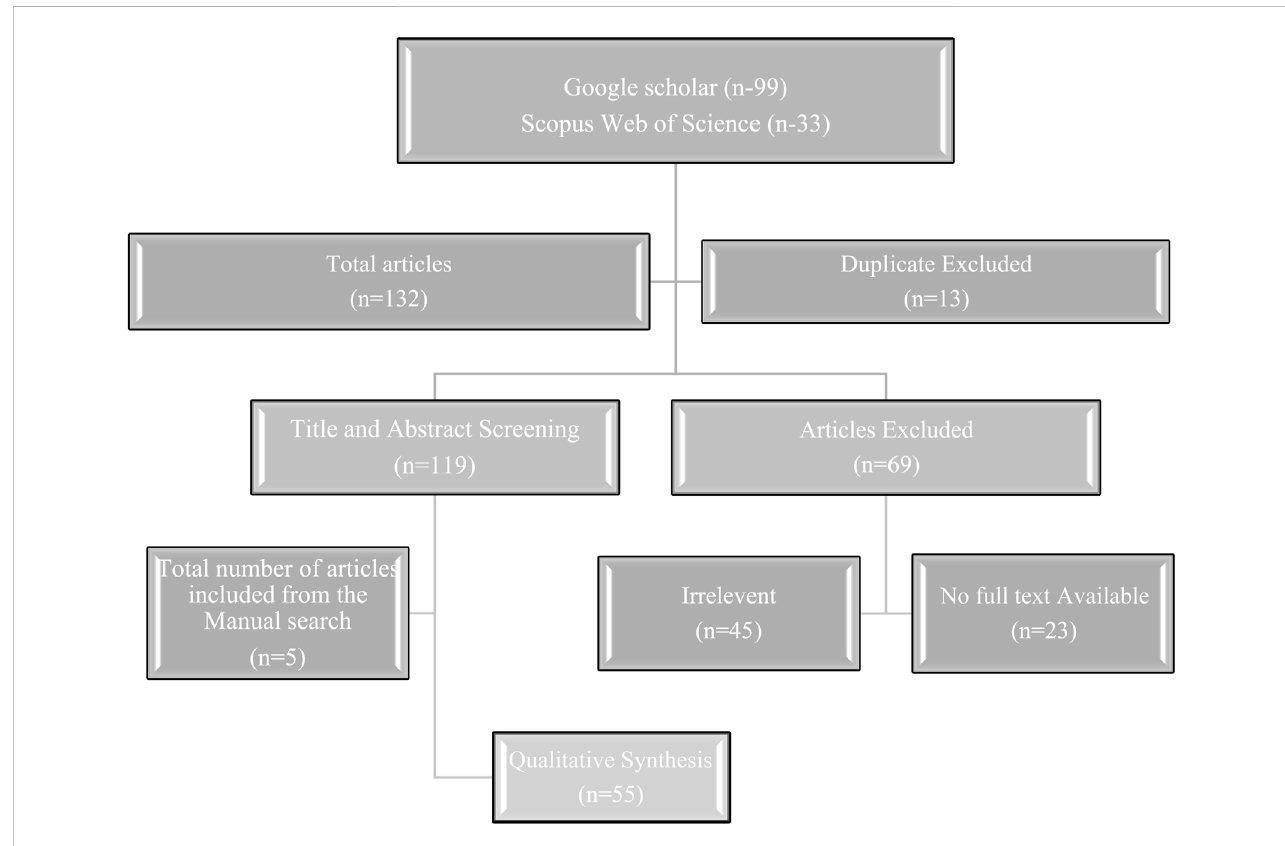
FIGURE 2 Flow diagram of studies ’ screening and selection (Source: Authors,